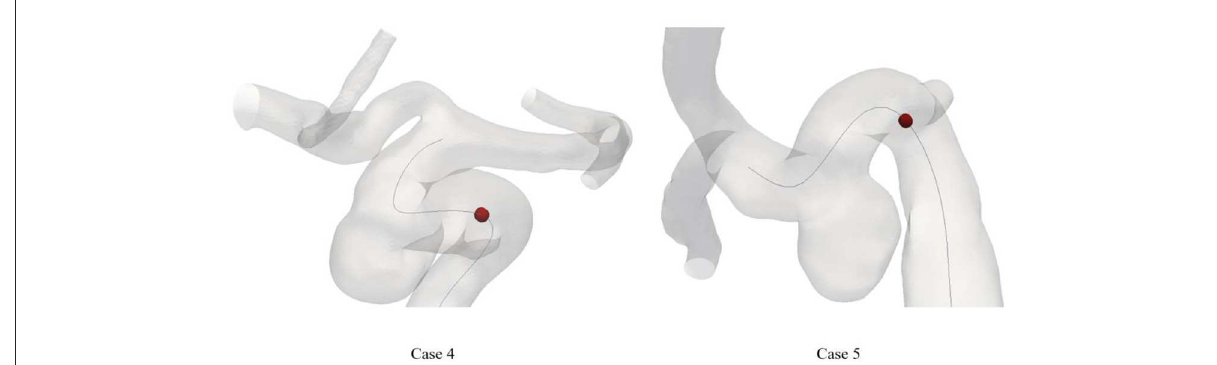
FIGURE3 The location of maximum curvature point on skeleton of patient. The dark line means the skeleton. The maximum curvature point was plotted as a red